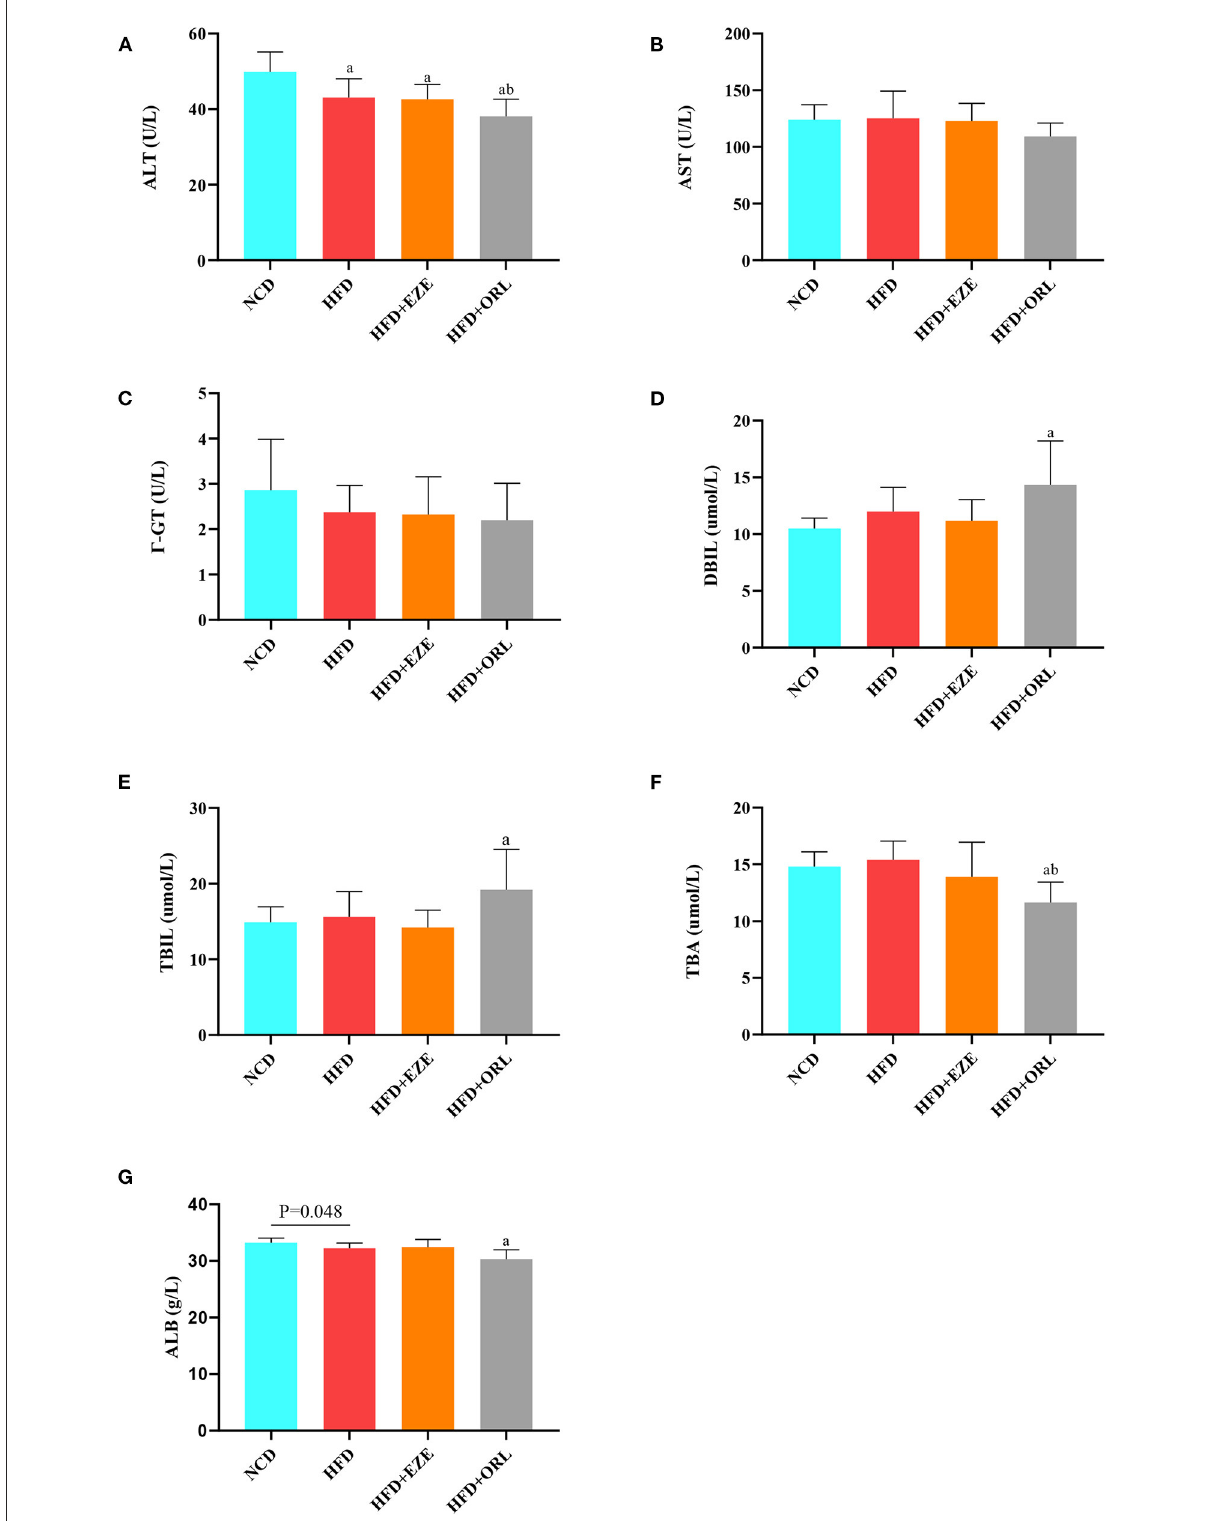
FIGURE3 Liver function levels of mice in different groups. (A) Serum alanine aminotransferase (ALT) levels; (B) serum aspartate aminotransferase (AST) levels; (C) serum Γ -glutamyl transpeptidase ( Γ -GT) levels; (D) serum direct bilirubin (DBIL) levels; (E) serum total bilirubin (TBIL) levels; (F) serum total bile acid (TBA) levels; and (G) serum albumin (ALB) levels. a: P < 0.05 compared with the NCD group. b: P < 0.05 compared with the HFD group. NCD, normal diet; HFD, high-fat diet; HFD + EZE, high-fat diet and intervention of ezetimibe; HFD + ORL, high-fat diet and intervention of orlistat; n = 10 per